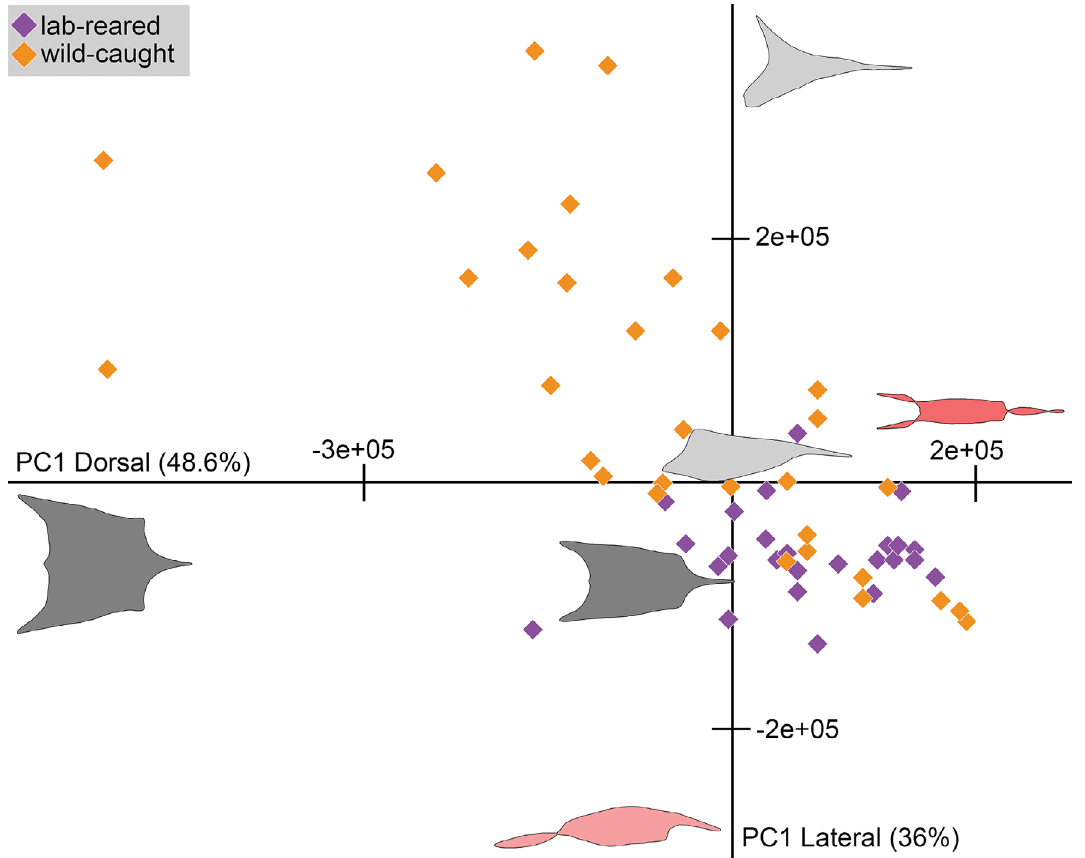
Figure 8. Plot of principal components from the PCA on the SHAPE analysis of shield outlines of Stomatopoda. PC1 of the dorsal analysis plotted against PC1 of the lateral analysis. Shapes included are from graphical component loadings and depict the mean shape of the principal component and +/-2 standard deviations of the mean shape. Color coding: dark grey: shapes of PC1 from the dorsal analysis; light grey: shapes of PC1 of the lateral analysis; dark red: impossible shapes of PC1 from the dorsal analysis; light red: impossible shapes of PC1 of the lateral